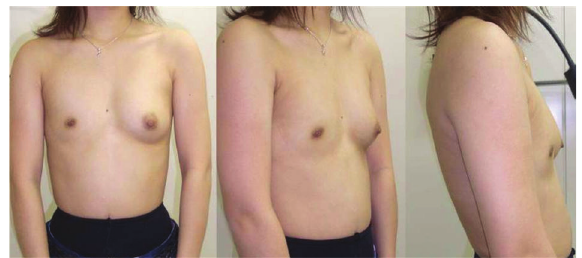
Figure 1: Preoperative view.